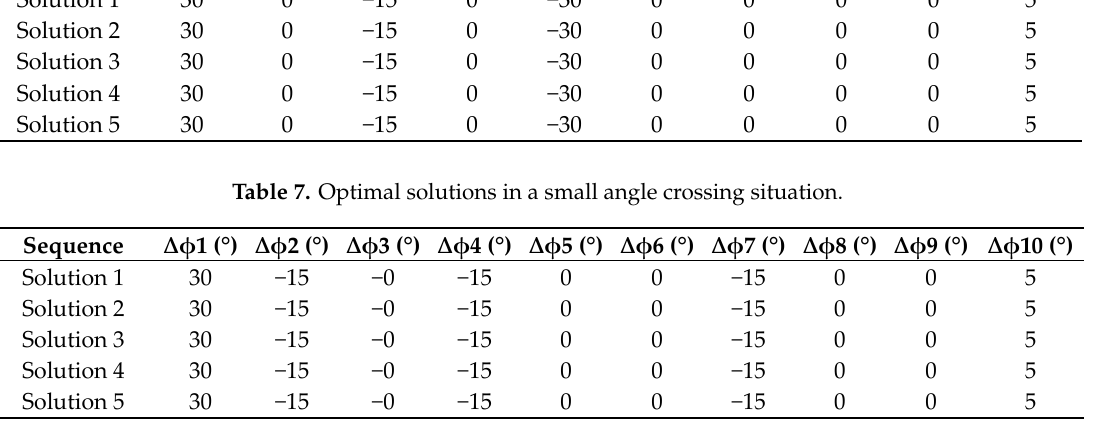
Table 8. Optimal solutions in an overtaking situation.